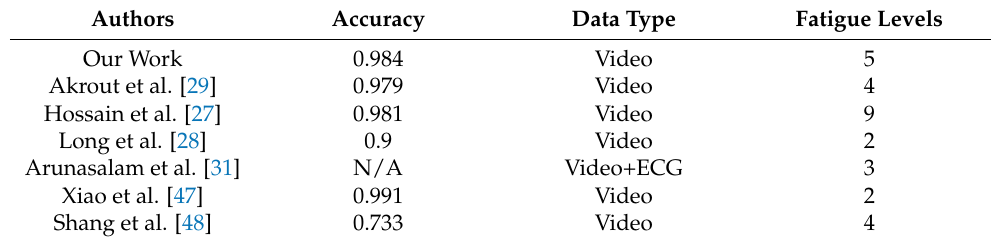
Table 6. Comparison of our approach to others in the